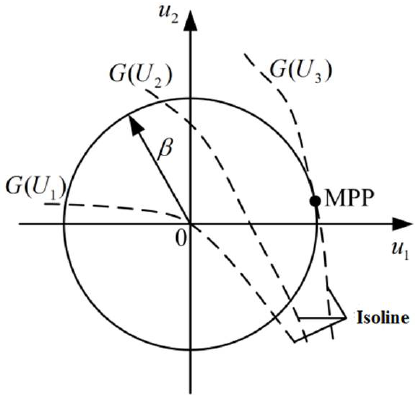
Figure 1. PMA theory in standard normal space.